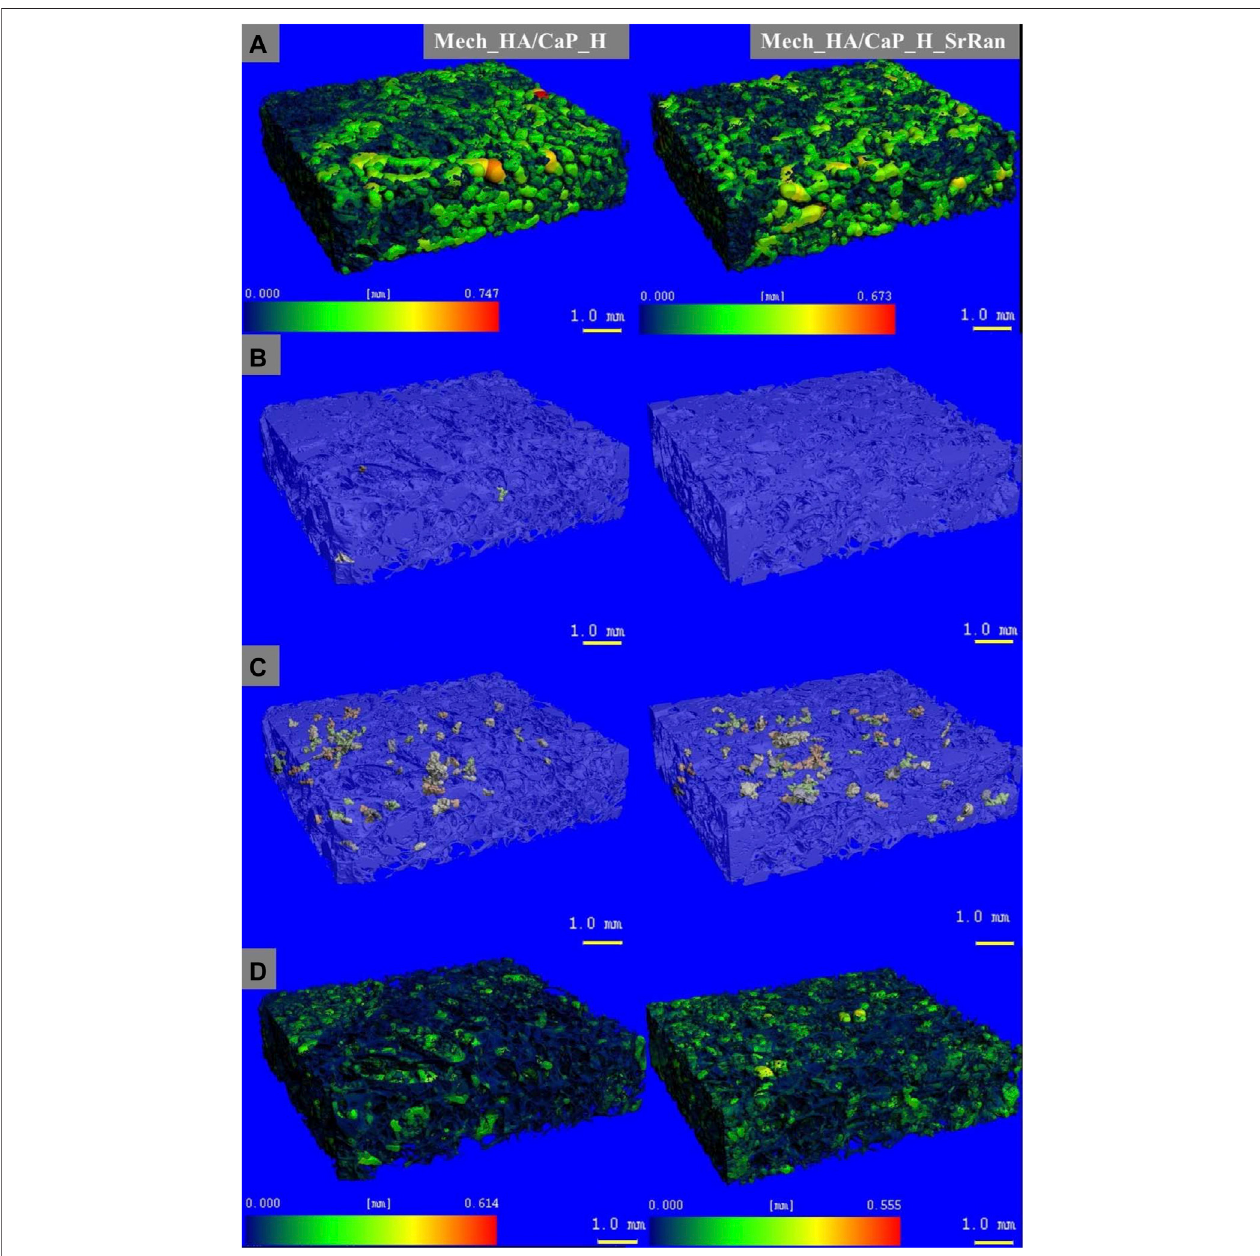
FIGURE 4 | Microstructure visualization of Mech_HA/CaP hydrogels. (A) Heatmap of pore size distribution; (B) closed pores; (C) slightly connected pores; (D) heatmap of pore wall thickness.